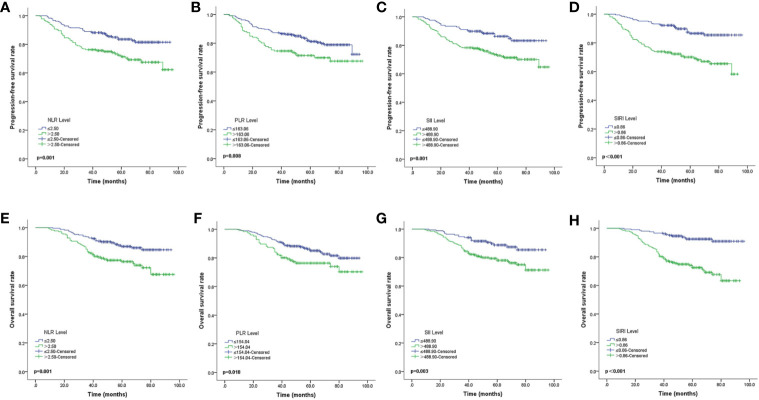
Kaplan-Meier survival curves of locally advanced NPC patients (A–D). Kaplan-Meier curves for PFS according to NLR (A), PLR (B), SII (C) and SIRI (D) (E–H). Kaplan-Meier curves for OS according to NLR (E), PLR (F), SII (G) and SIRI (H). PFS, progression-free survival; OS, overall survival; NLR, neutrophil-to-lymphocyte ratio; PLR, platelet-to-lymphocyte ratio; SII, systemic immune inflammation index; SIRI, systemic inflammation response index.